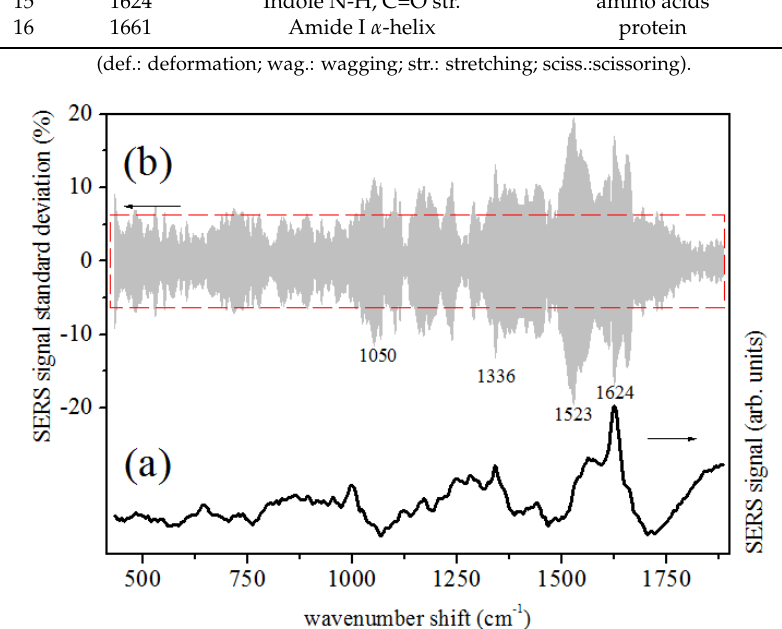
Figure 2. ( a ) Human tear SERS signal. ( b ) SERS signal standard deviation with respect to the average signal (bottom spectrum) of tears. The red box indicated the mean value of the signal standard deviation (6.3 ±